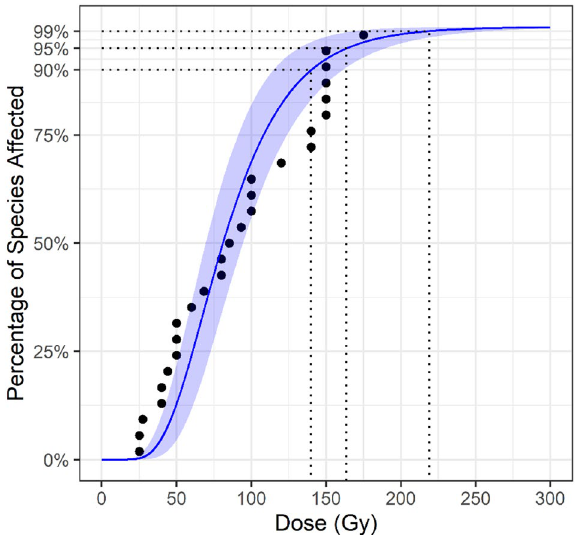
Figure 3. SSD Curve for Curculionidae using interval-censored data with the shaded area covering the 5–95% confidence interval. Points are fitted to the log-normal distribution.